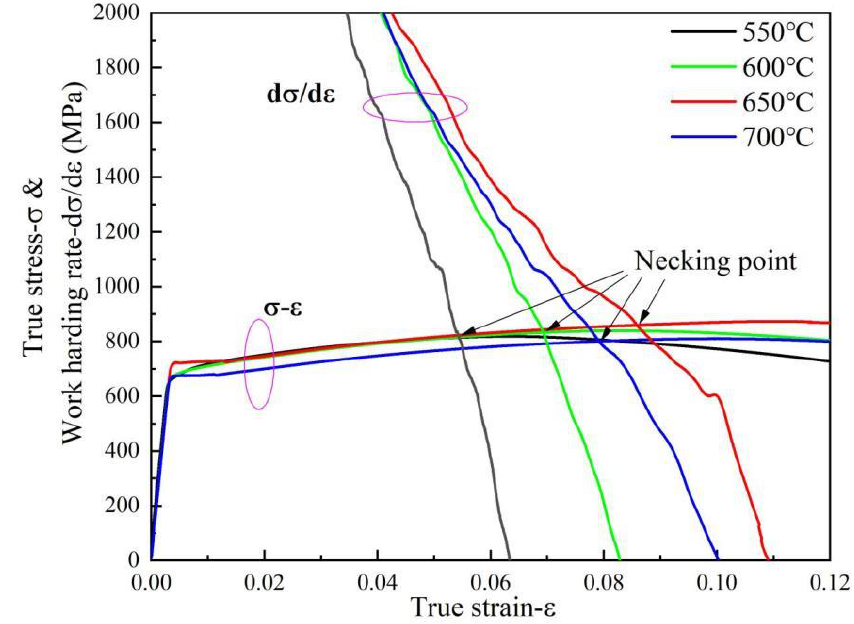
Figure 11. True stress and work-hardening rate curves versus true strain.